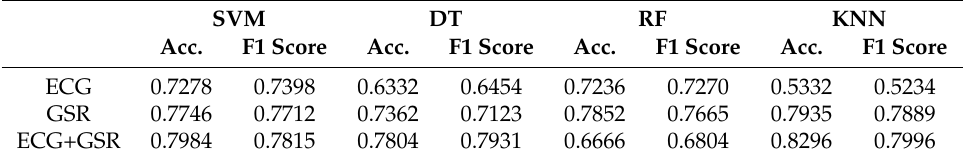
Table 3. Classification results using different feature sets with leave-one-subject-out validation